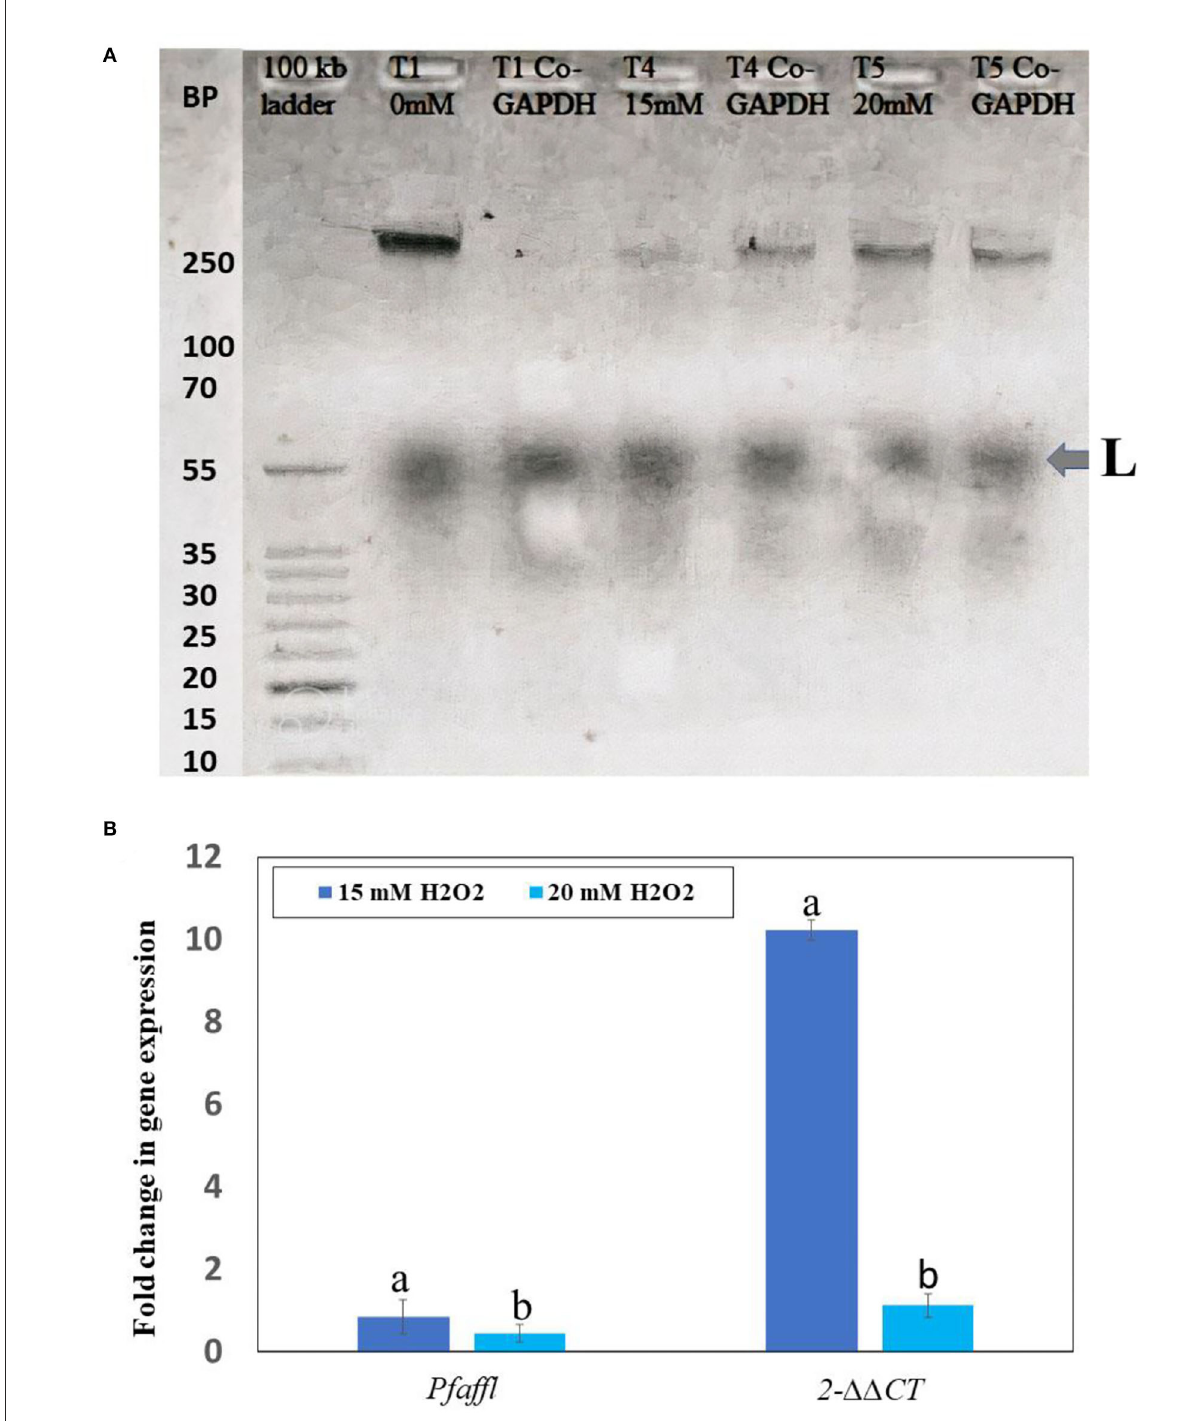
FIGURE8 The result of RT-PCR when viewed under gel electrophoresis (A) . The Pfaffi and 2 − 11 CT methods were used to analyze the fold change in rubisco ( rbcL ) gene expression in the control, 15mM and 20mM H 2 O 2 treated plants (B) . Bars indicate ( ± S. E.). Means followed by the same lower case letters within the column are not significantly different according to Tukey’s HSD-test (n = 3, p ≤ 0.05